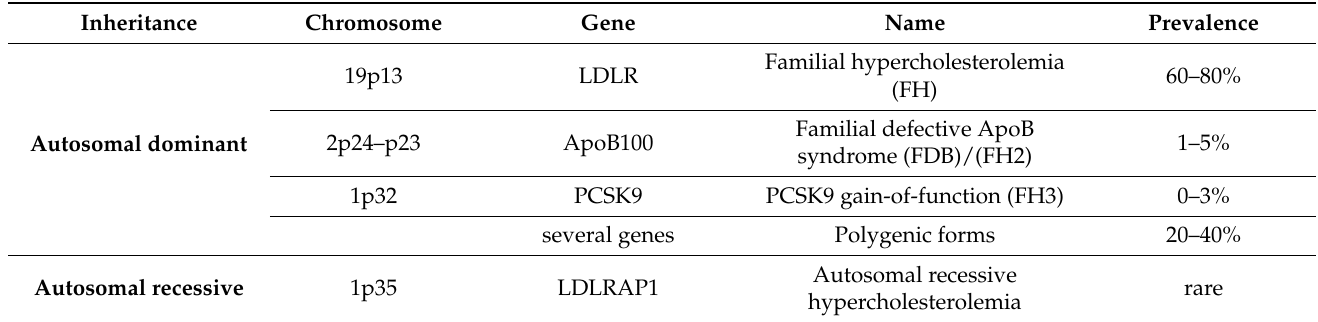
Table 1. Genetic deviations in the background of FH syndrome